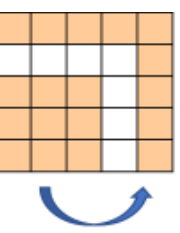
Figure 3. The Pythagorean Rule in the Domain of Natural Numbers, e.g., 3 2 + 4 2 = 5 2